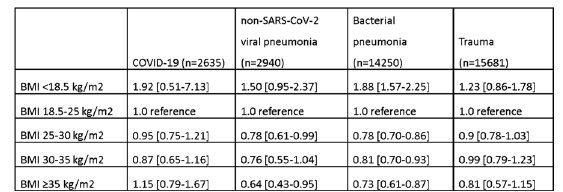
Fig. 1 Relative in-hospital mortality risks according to BMI in the four cohorts. BMI of 25.0 kg/m 2 was used as Reference. Relative risks were adjusted for sex, age, chronic diagnosis, APACHE III acute physiology score (APS) and need for mechanical